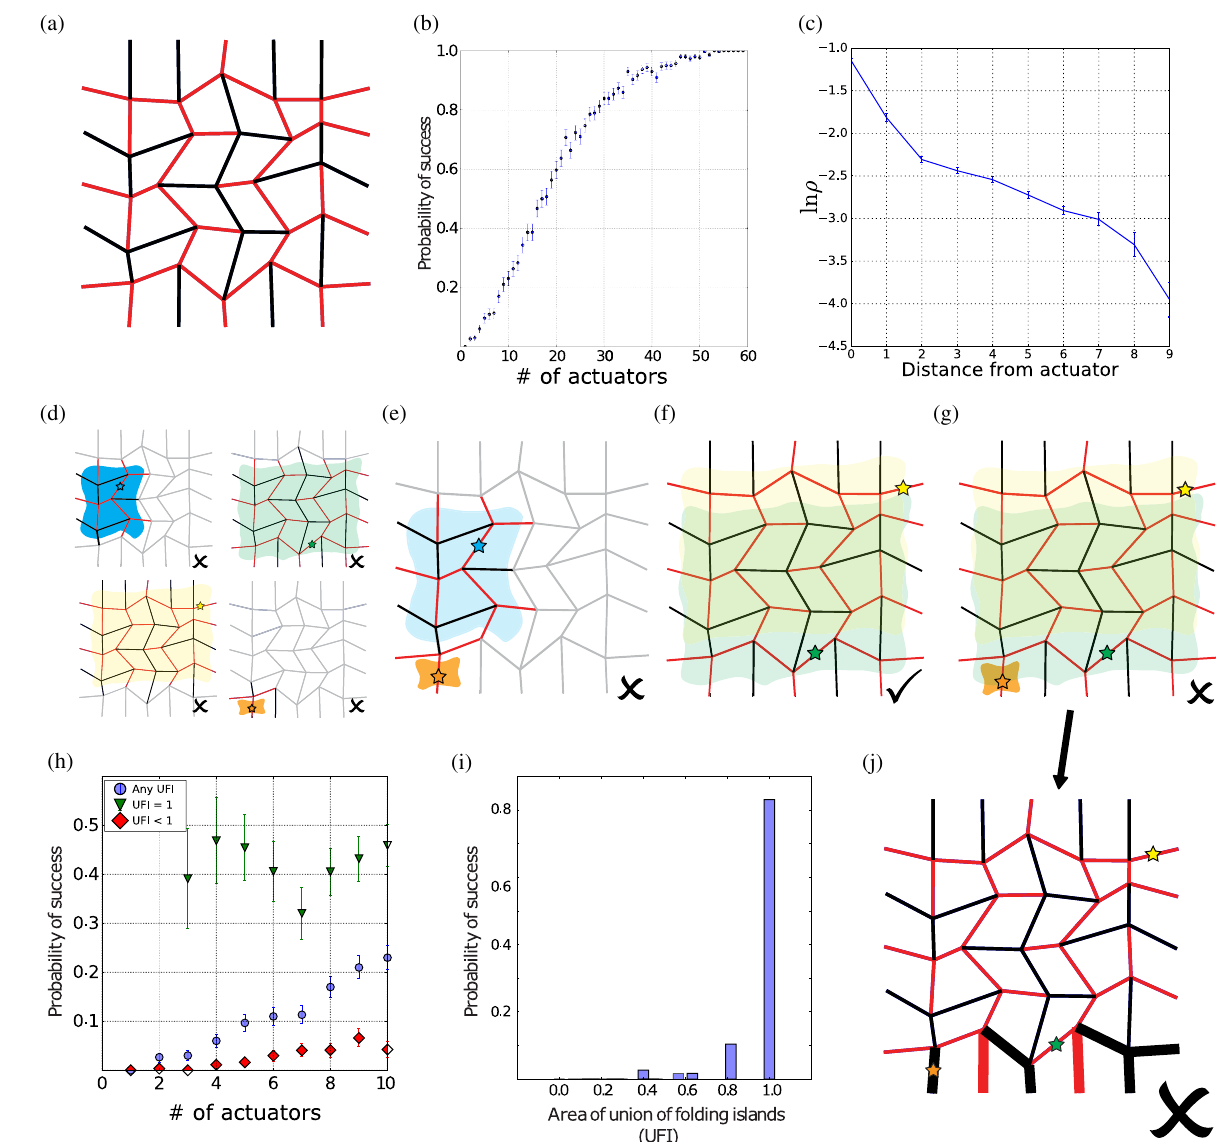
FIG. 5. Spatial distribution of actuators determines folding success. (a) A 4 × 4 quadrilateral mesh pattern, with their designed soft branch indicated by line colors (black for mountain, red for valley). (b) If standard actuators are placed on randomly chosen creases of the pattern, at least 18 actuators ( ∼ 30% of creases) are needed to have a 50% chance of successful folding. (c) If just one crease is pressed, the resulting branches typically have a decreasing folding magnitude for creases away from the actuated crease. (d) The folding island of a crease is the largest subpattern that folds correctly when cut out from the full pattern and actuated at that crease. The area of the union of folding islands (UFI) relative to the entire pattern provides a simple design heuristic. (e) Actuated crease sets with UFI < 1 generally do not successfully fold the pattern while (f) actuators with UFI ¼ 1 are successful. (g) However, successful actuation can sometimes be ruined by actuating an additional crease (orange) with a small folding island. (h) Actuated crease sets of a given size are dramatically more likely to fold successfully if their UFI ¼ 1 (green) rather than UFI < 1 (red). (i) Using the data in (b), we find that UFI is a sharper predictor of success than the number of actuators. (j) Folding islands also explain a counterintuitive effect where successful actuation can sometimes be ruined by actuating an additional crease (orange) with a small folding island. The obtained branch is different than the designed one primarily in creases close to the “ bad ” actuator (thick